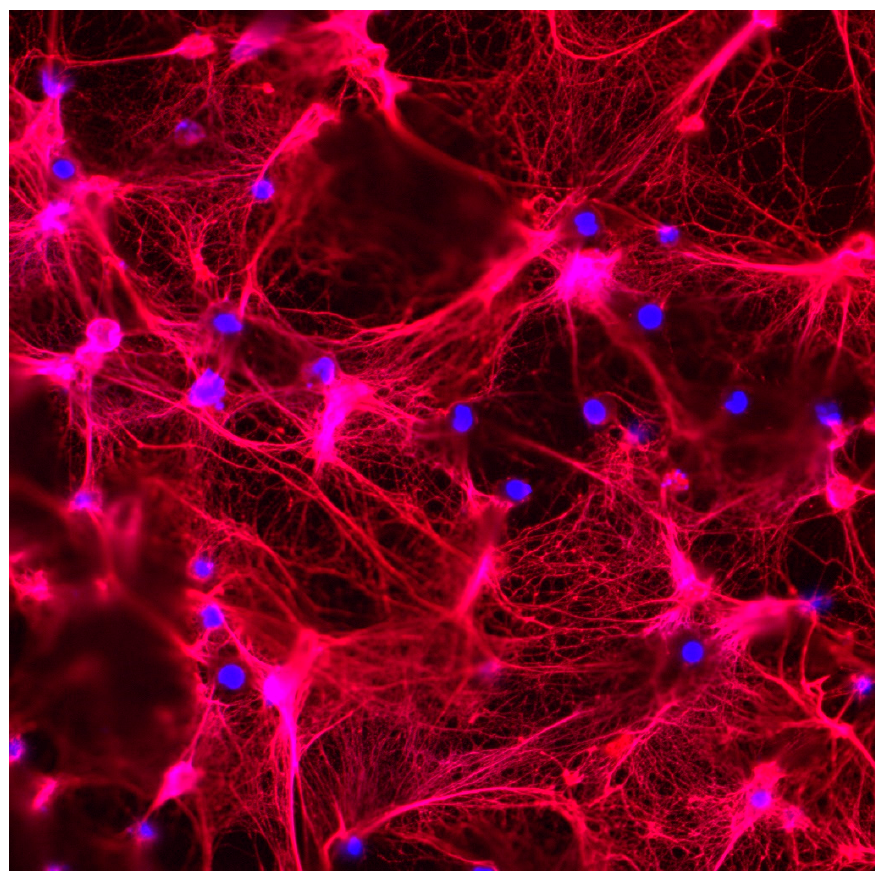
Figure 2. Low-density granulocytes (LDGs) from SLE patients display enhanced NET formation. Immunofluorescence analysis shows that LDGs isolated from a lupus patient have the propensity to form exuberant NETs in vitro. Red is myeloperoxidase (MPO); blue is DNA. Original magnification 400×.